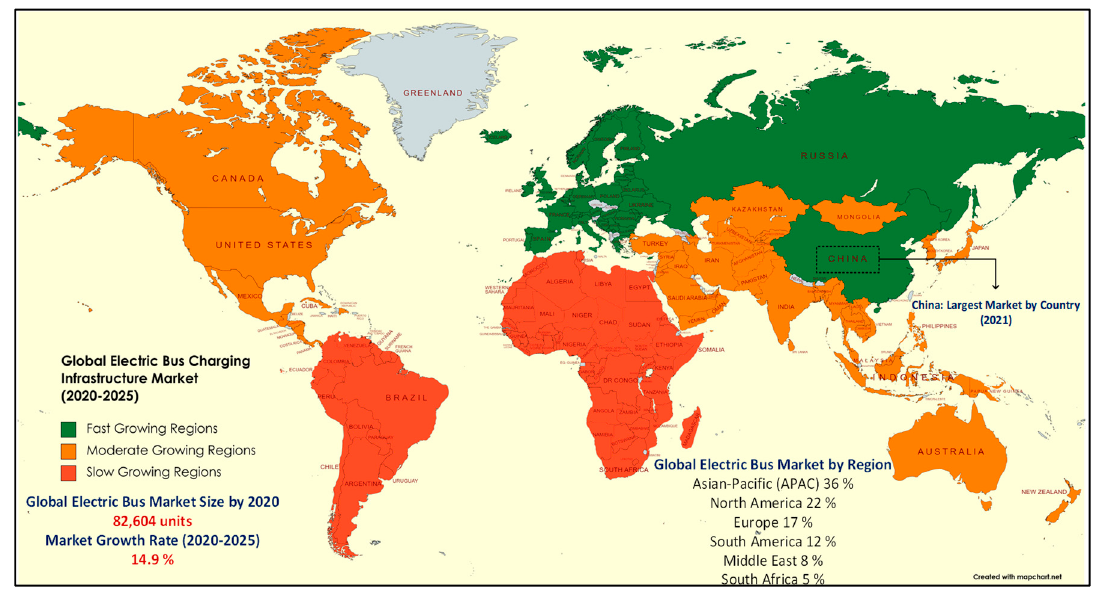
Figure 2. Global E-Bus charging infrastructure [6].